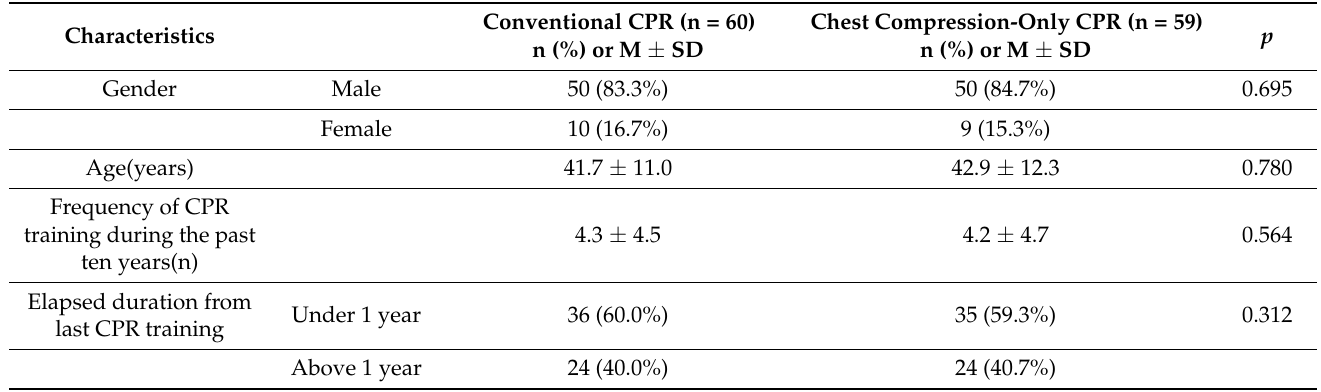
Table 1. Homogeneity demographic characteristics.